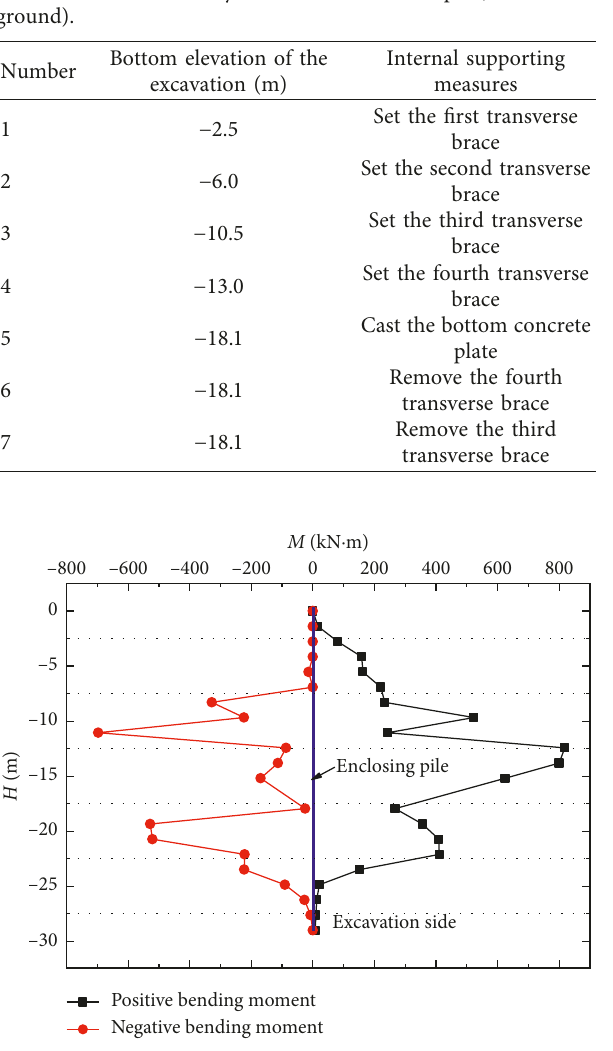
Figure 7: Bending moment envelope diagram of retaining piles.